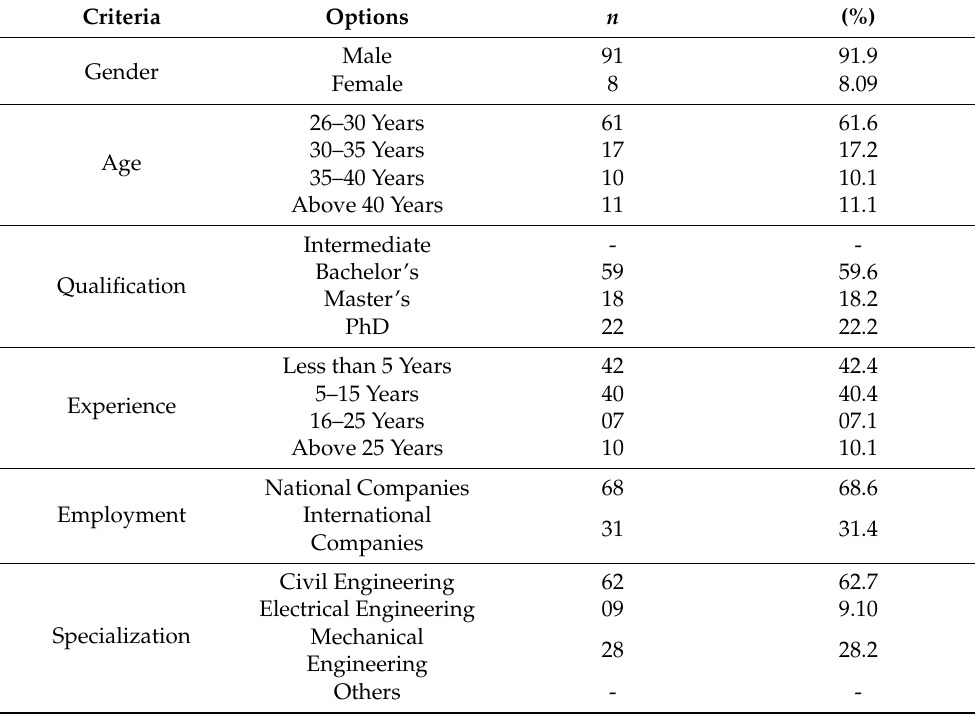
Table 2. Demographic information of